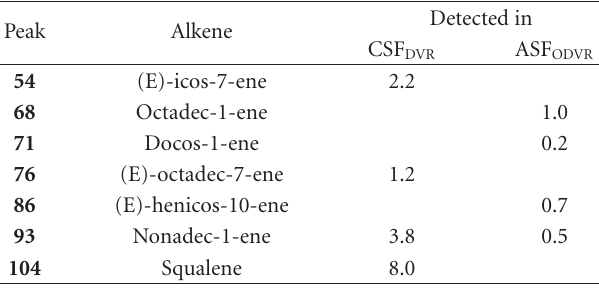
Table 2: Alkenes detected in the products from CSF DVR and ASF ODVR .